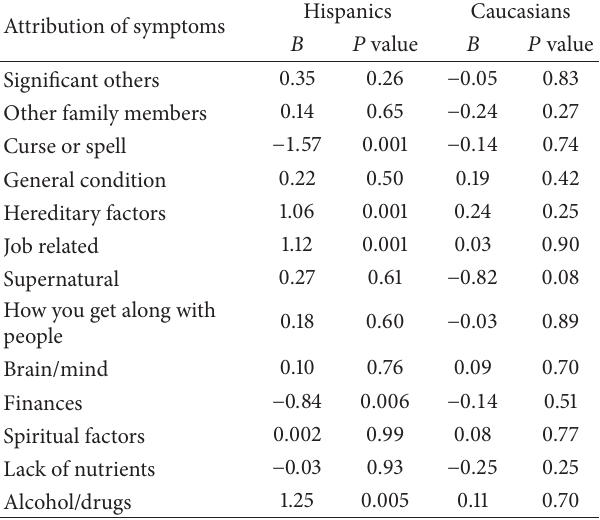
visits or prior treatment records (i.e. they are